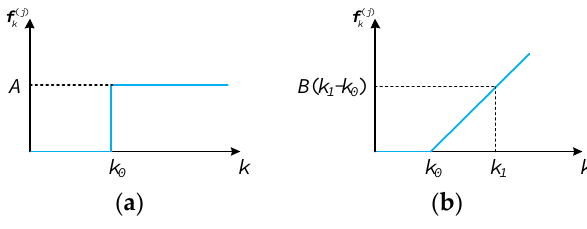
Figure 4. The diagrams of the step error and the ramp error. ( a ) Step error; ( b ) Ramp